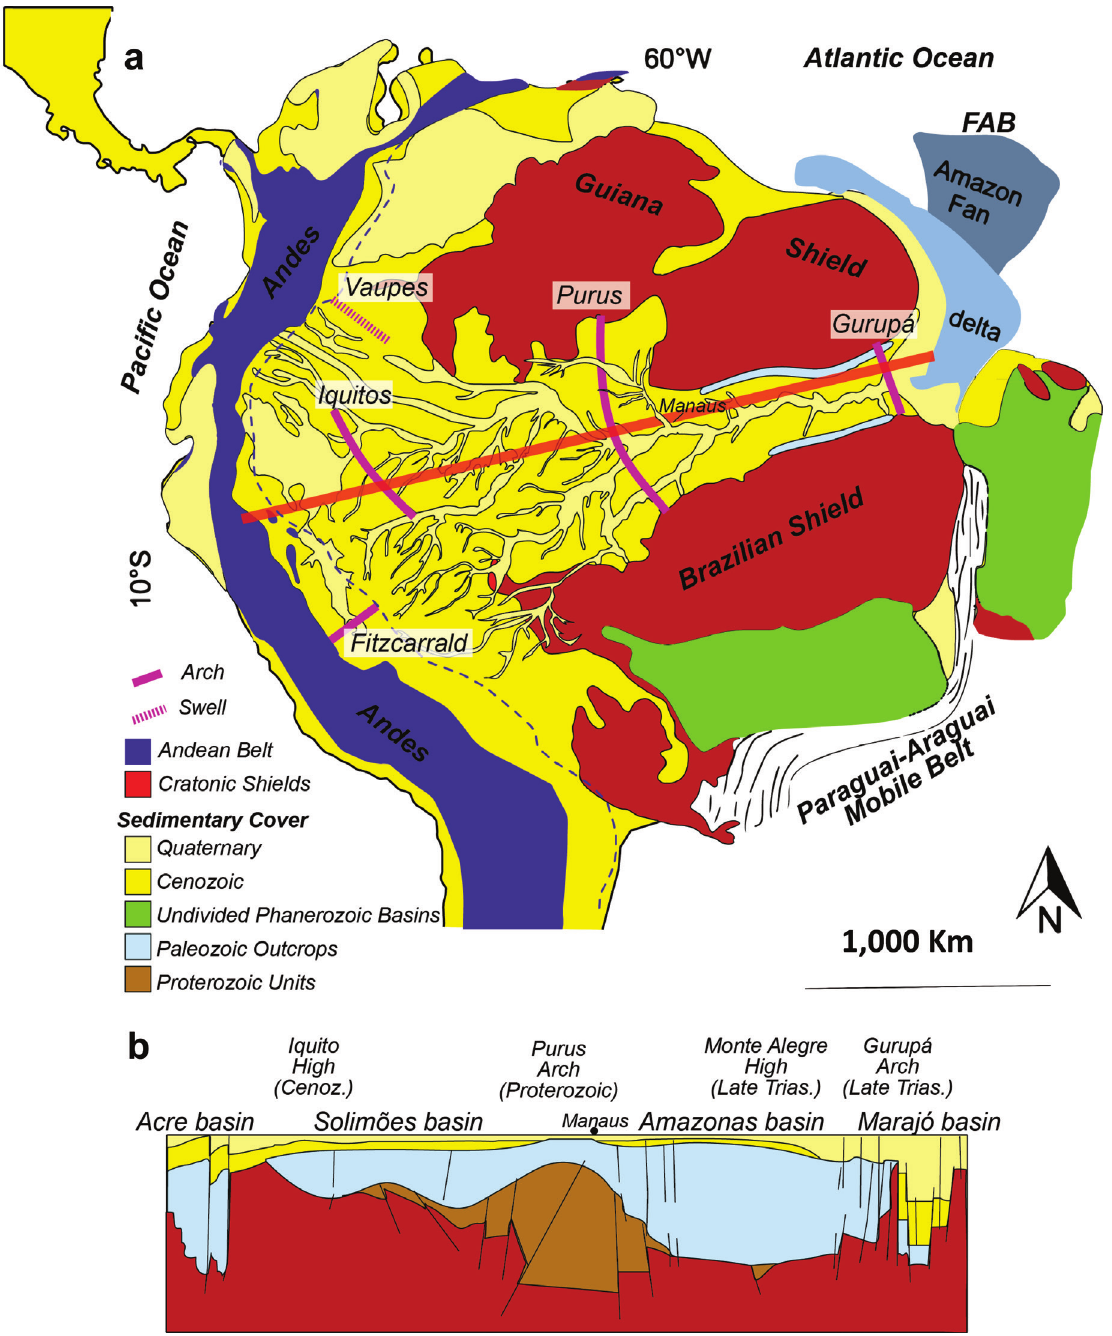
Fig. 1. Geological map of northern South America. a. Geological units that formed the provenance area for the sediment input into the Amazon subaqueous delta and submarine fan (adapted from Hoorn et al. , 2017). FAB, Foz do Amazonas Basin. b. Schematic longitudinal section (orange bar) of the Amazon river basin showing sedimentary basins and structural arches (adapted from Wanderley-Filho et al ., 2010; Caputo, Soares 2016). separation of western Amazonian basins from the Orinoco basin by the rise of the Vaupés Arch (Mora et al ., 2010). twards across the whole of northern South America and into the Atlantic, depositing Andean-derived sediments at or near the mouth of the modern Amazon